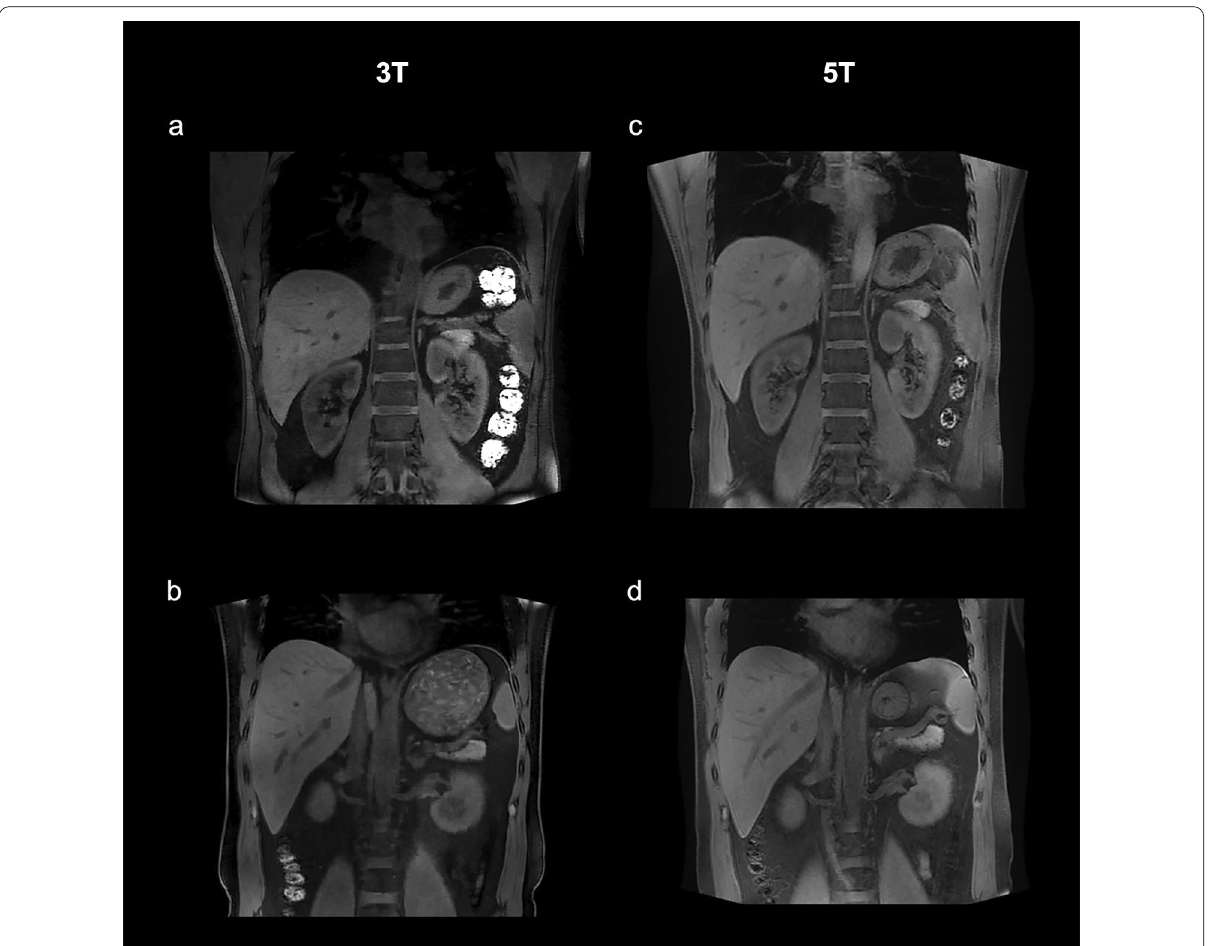
Fig. 1 T1-weighted images of a 46-year-old male. a , b Coronal, breath-hold T1-weighted gradient-echo (GRE) sequence at 3 T; c , d Coronal, breath-hold T1-weighted GRE sequence at 5